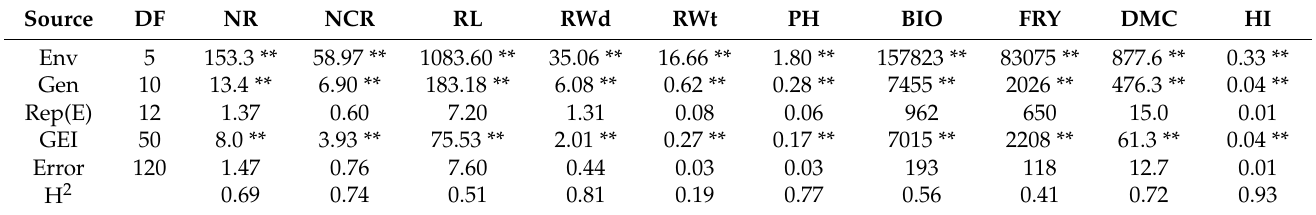
Table 1. Pooled ANOVA showing mean squares and percentage of total variance explained for yield and yield related traits of the cassava genotypes evaluated across six environments in South Africa.